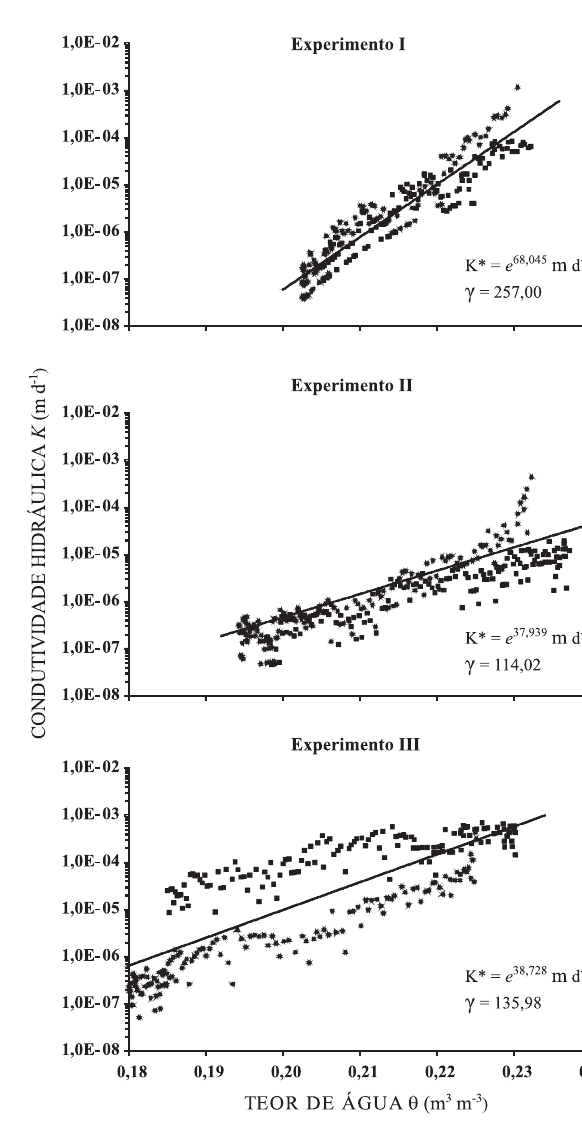
Figura 3. Condutividade hidráulica em função do potencial matricial para os experimentos I, II e III. Círculos representam dados obtidos entre as profundidades z obtidos entre as profundidades z